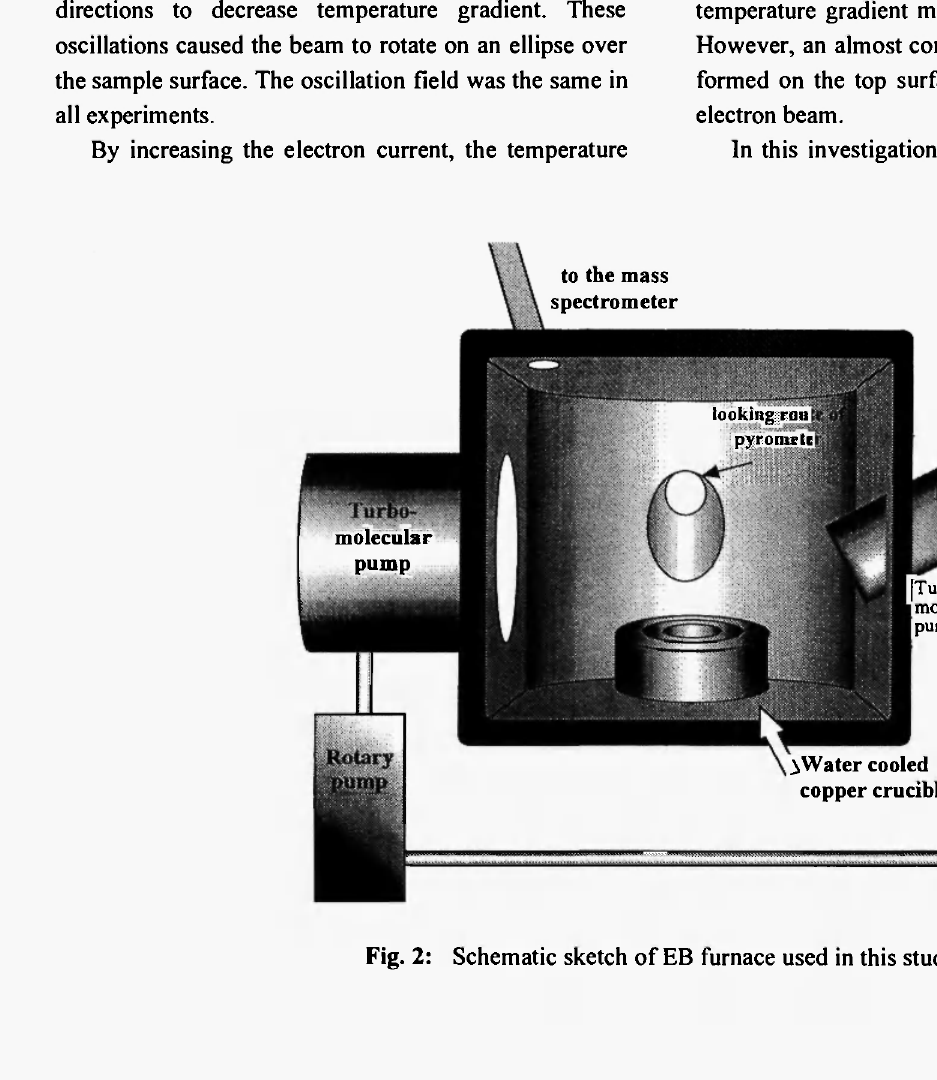
Fig. 2: Schematic sketch of EB furnace used in this